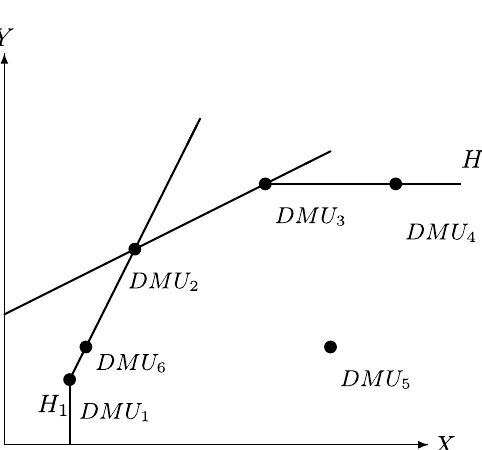
Fig. 1 Extreme, non‑extreme and anchor